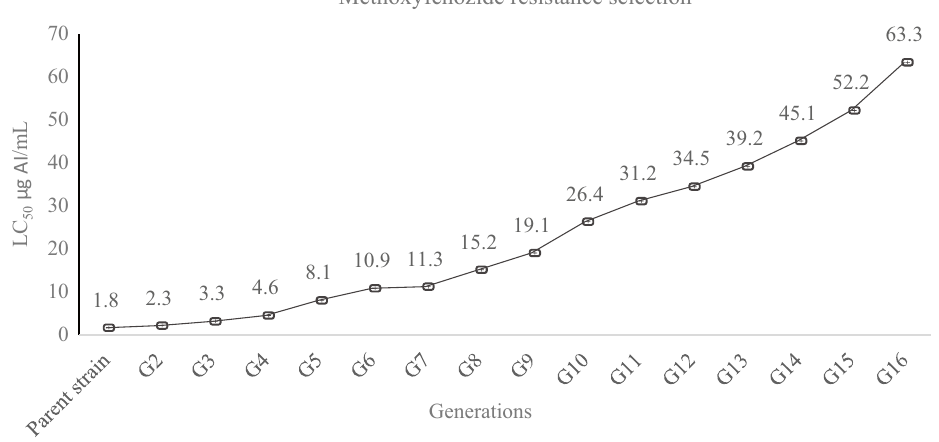
Figure 1. The LC 50 (μg/mL) values of methoxyfenozide during selection with increasing concentrations towards S. littoralis second instar larvae over 16 generations.